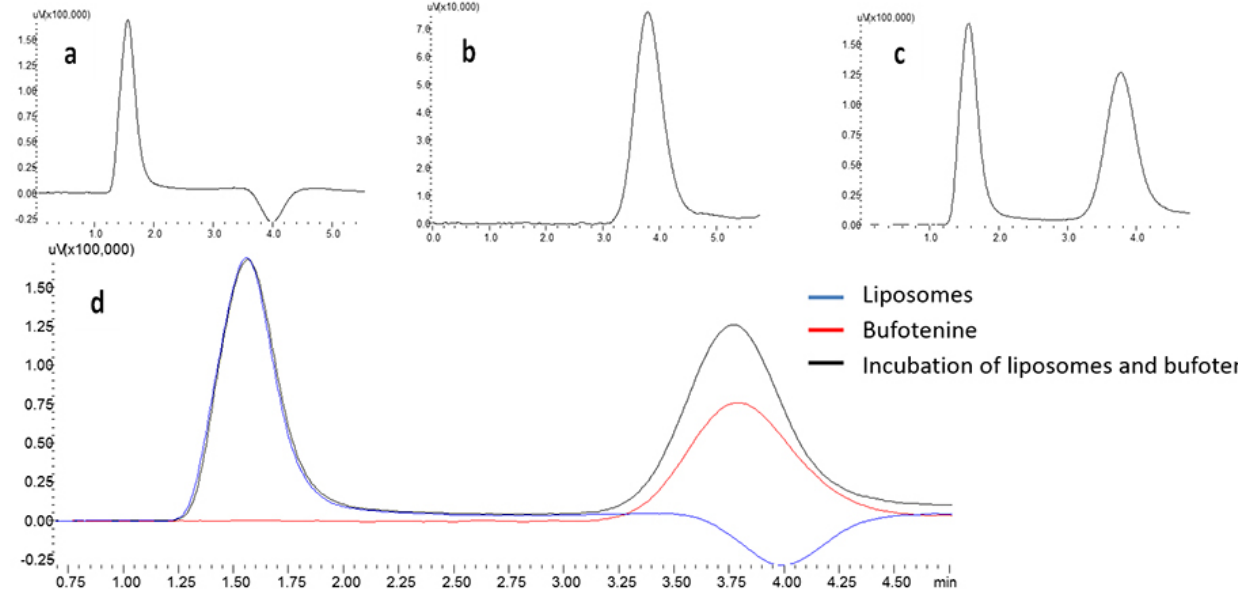
Figure 3. Analysis of bufotenine penetration in liposomes by size exclusion chromatography. (a) Positively charged liposome; (b) bufotenine; (c) incubation of liposome and bufotenine indicating no liposome penetration; (d) overlap of (a), (b) and (c) .